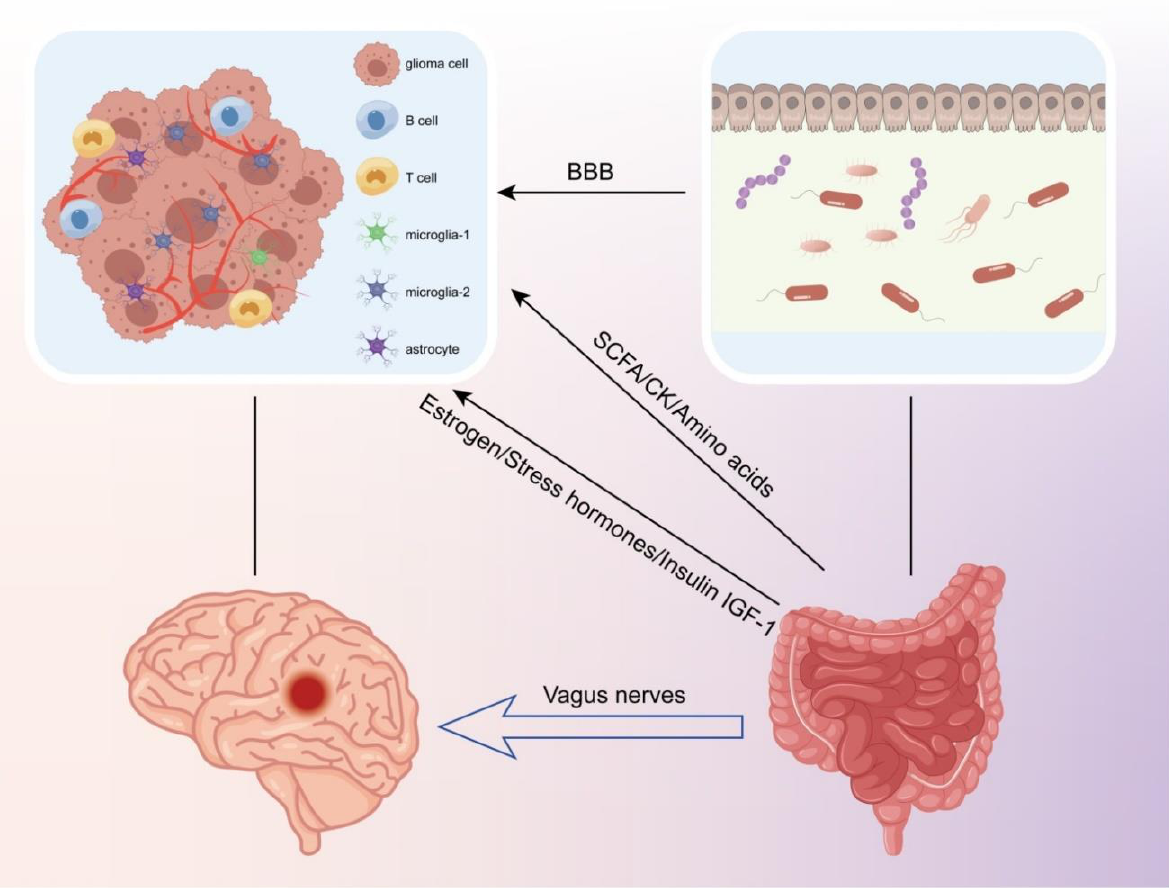
Figure 5. SCFAs and other metabolites produced by the gut flora can cross the blood–brain bar- rier(BBB) and affect glioma progression through neural, endocrine, and immune pathways. The gut flora can regulate glioma growth and apoptosis by modulating the levels of estrogen, insulin-like growth factor, and other hormones. The vagus nerve is also a key pathway for neural communication between the CNS and the gut microbiota.